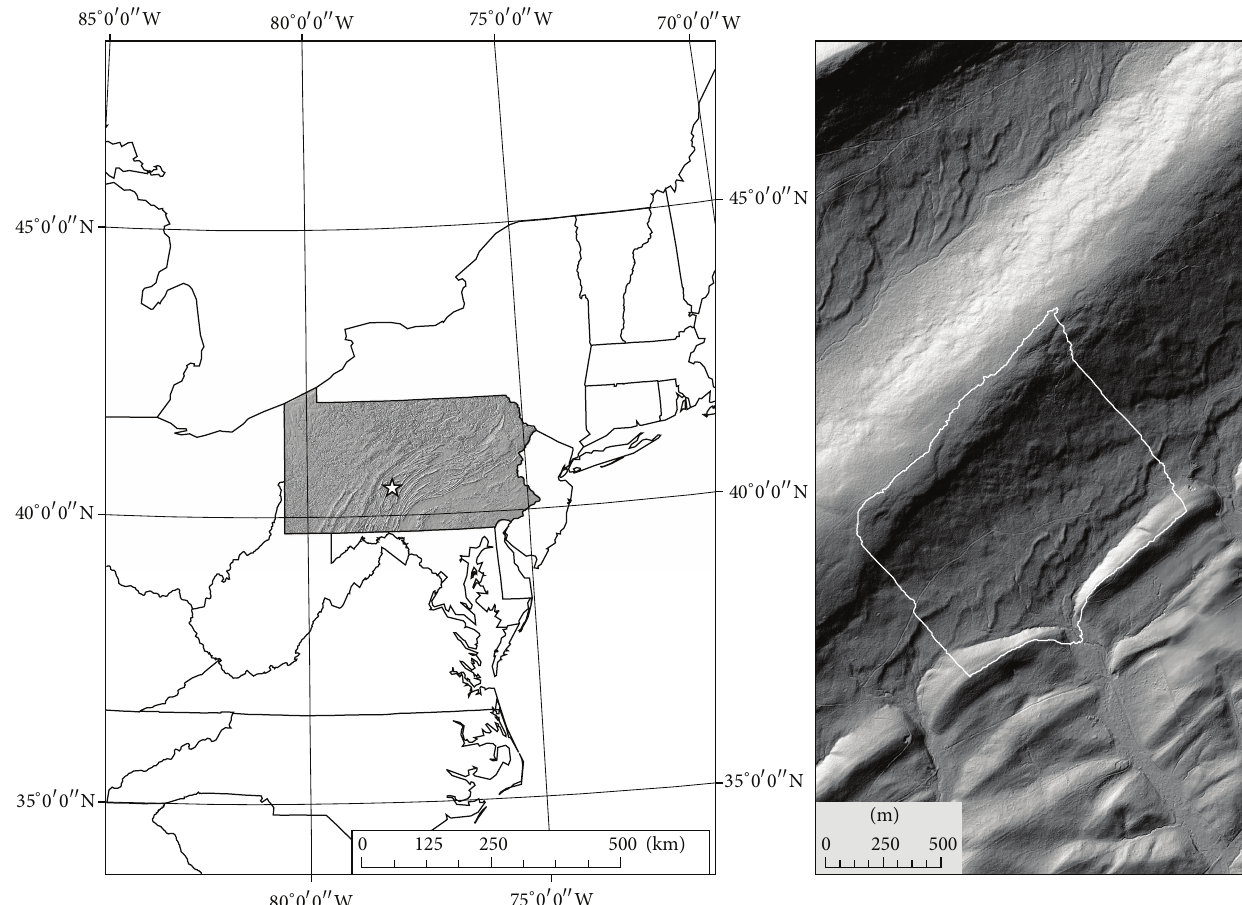
Figure 1: Site of the Leading Ridge Watersheds in Pennsylvania,